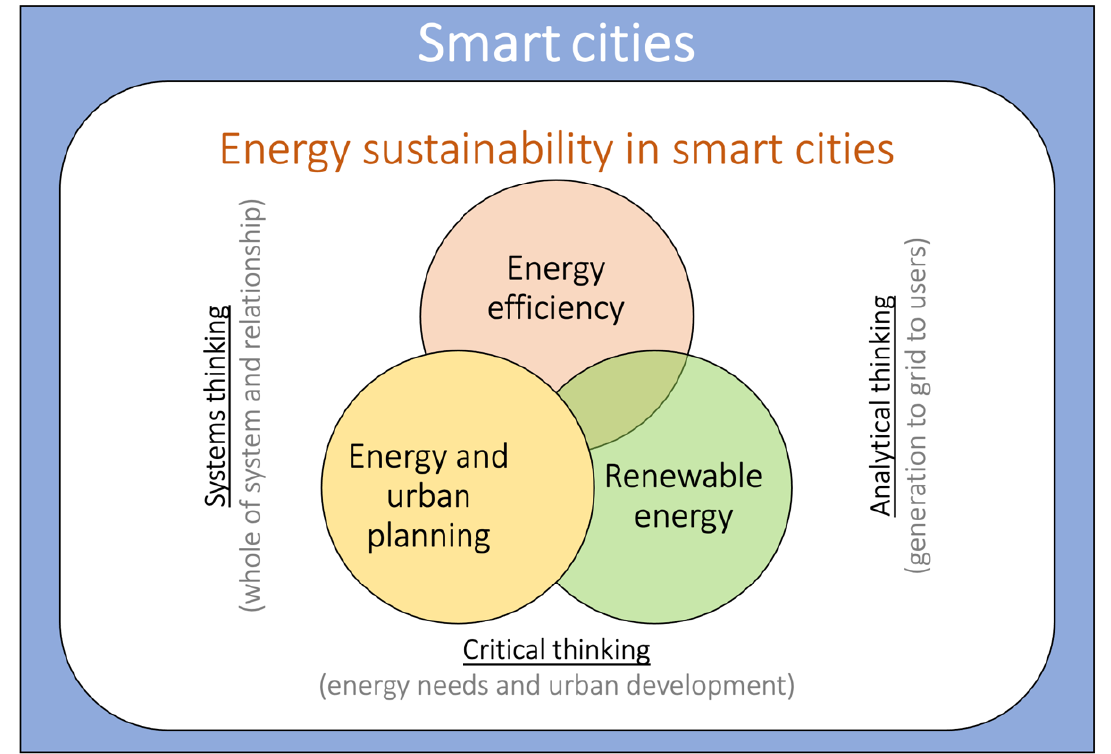
Figure 9. Conceptual model for energy sustainability in smart cities .